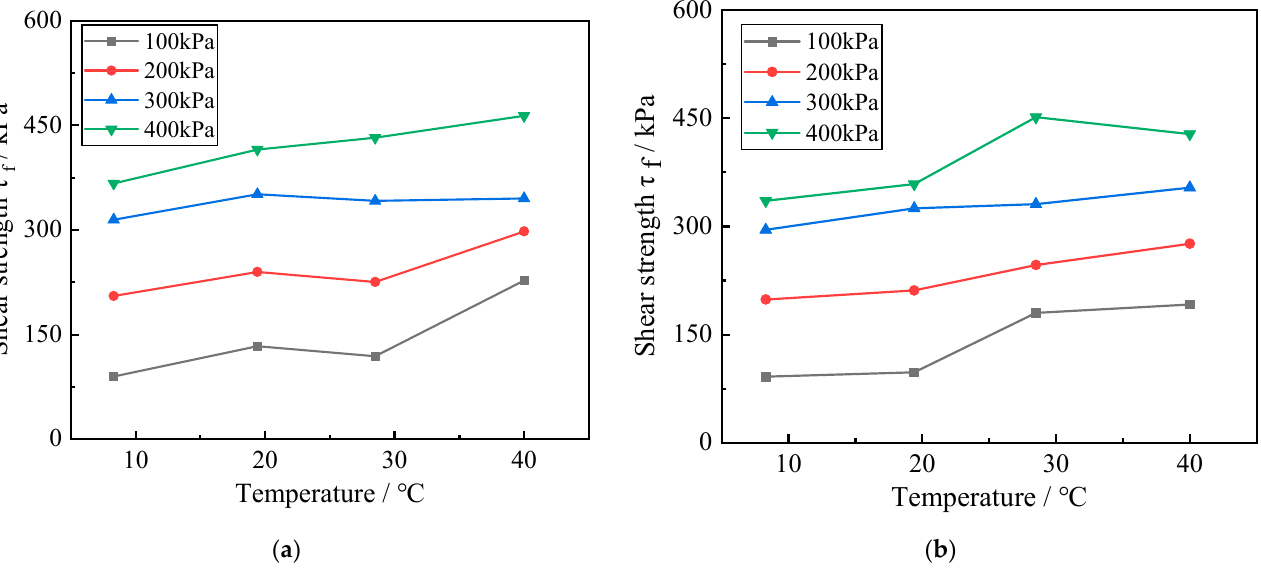
Figure 5. Influence of temperature on the shear strength of red clay. ( a ) The zinc ion concentration is 0%; ( b ) The zinc ion concentration is 0.5%.